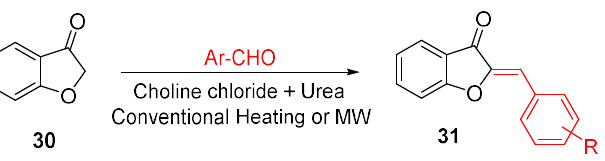
Scheme 2. Synthesis of ( Z )-2-benzylidenebenzofuran-3(2 H )-ones according to Hawkins and co- workers [54] and Taylor and co-workers [55].